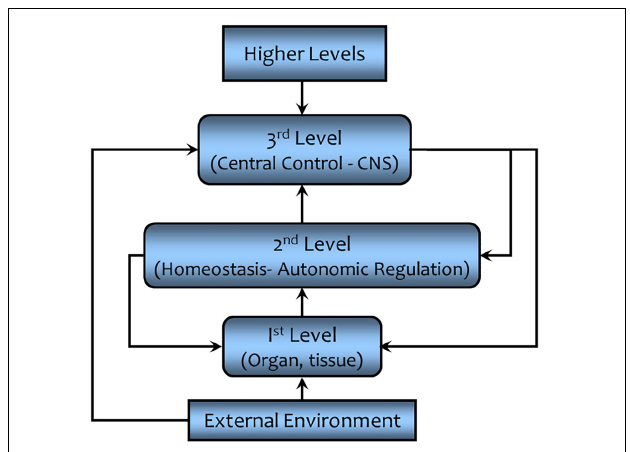
FIGURE 9 | A simplified schematic representation of the higher order control of homeostatic regulation. This hierarchical control results in a finer level of control and a greater flexibility that enables the organism to adapt to changing environmental conditions (see text for details). CNS = central nervous